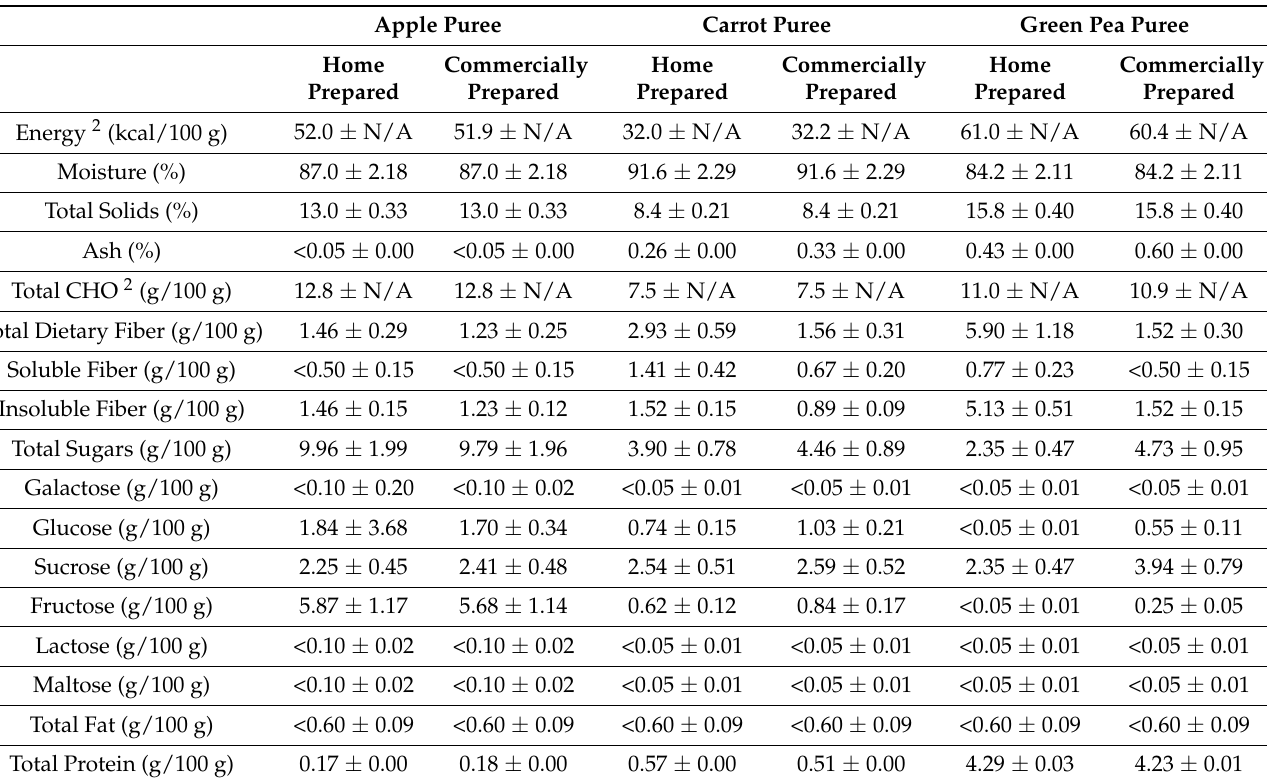
Table 5. Macronutrient profiles of the home prepared and commercially prepared purees, adjusted by total solids for moisture content 1